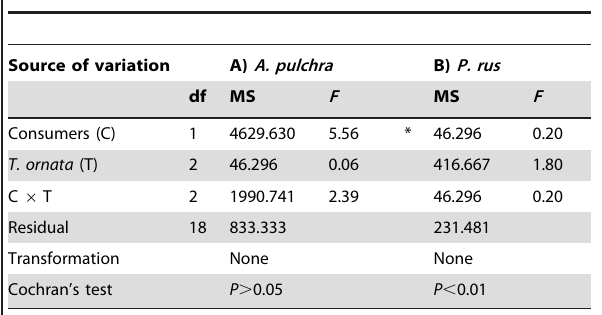
Table 1. ANOVA on the effects of Consumers (present versus excluded) and T. ornata (absent versus medium cover versus high cover) on the mortality of A) A. pulchra and B) P. rus ).